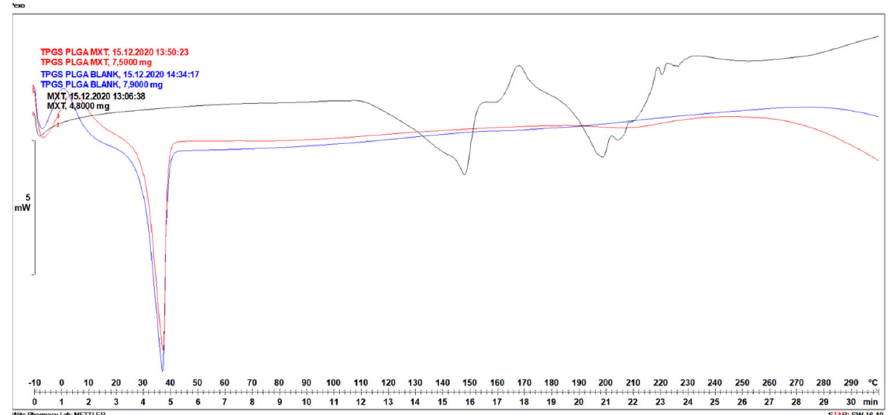
Figure 6. DSC curves of the methotrexate ‐ loaded in polymeric TPGS ‐ PLGA nanoparticles.